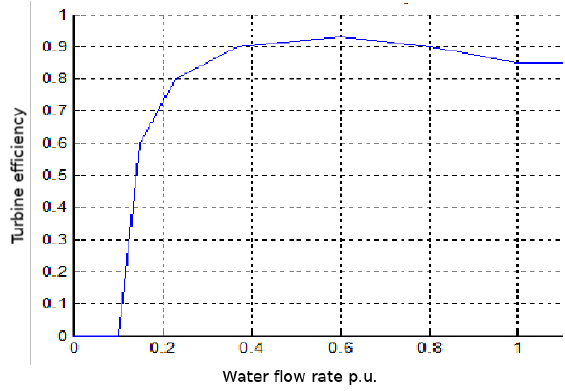
Figure 2. Pelton turbine efficiency vs. water flow rate